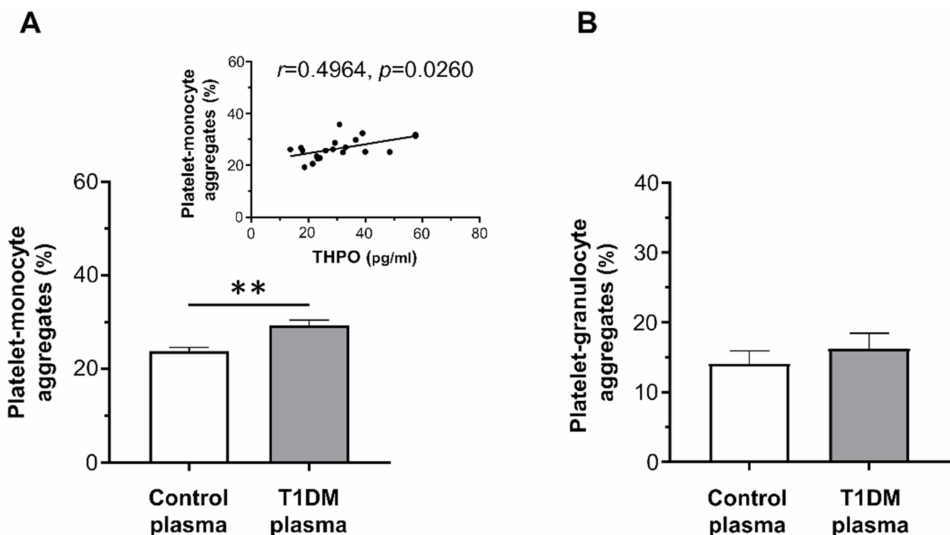
Figure 4. In vitro effect of plasma from healthy subjects and type 1 diabetic patients on epinephrine (EPI)-induced platelet–monocyte ( A ) and platelet–granulocyte binding ( B ), as analyzed by flow cytometry in whole blood. Data were represented as mean ± SE. p -values by unpaired t -test (( A ) ** p < 0.01; ( B ) not statistically